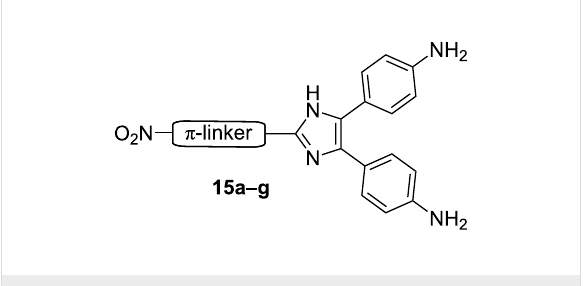
Figure 6: General structure of 4,5-bis(4-aminophenyl)imidazole- derived chromophores 15a – g with various π -linkers [16,17,47].